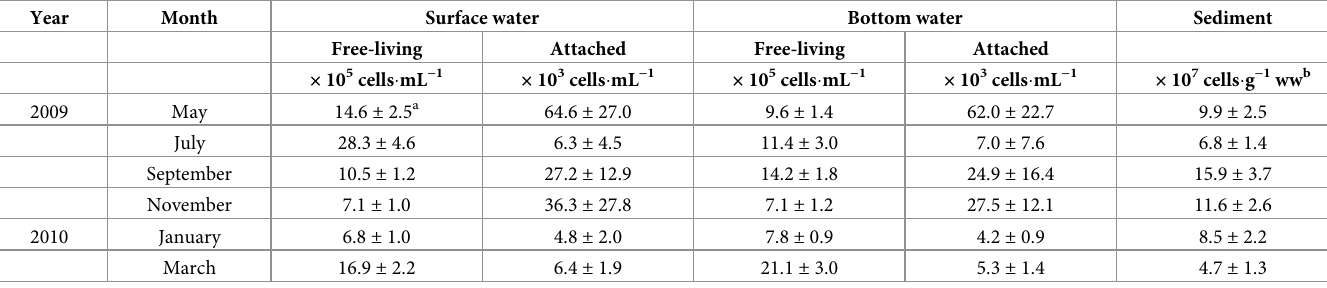
Table 2. Bacterial concentrations at the sampling